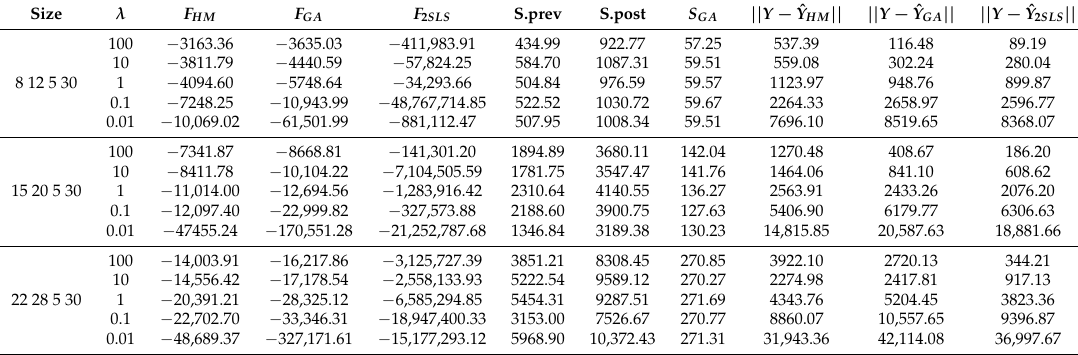
Table 2. Average results for fitness, run time and accuracy (over 5 simulation runs) of different estimation